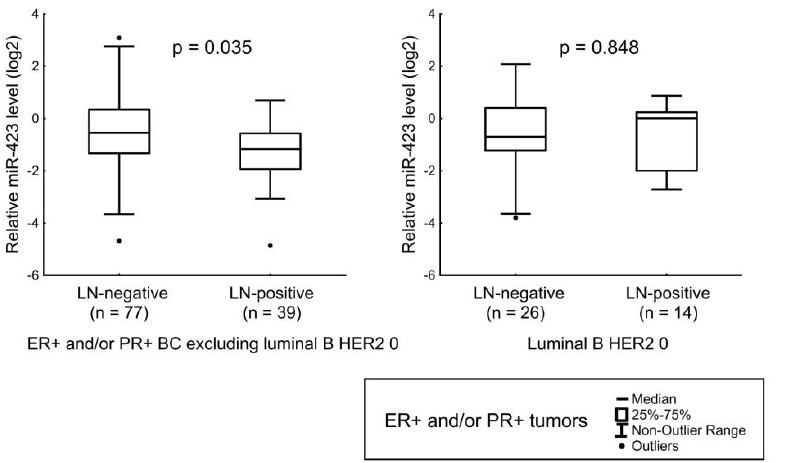
Figure 7. Relation of miR-423 level with LNM in luminal A, luminal B HER2-amplified, and luminal B HER2 1+ tumors (left); relation of miR-423 level with LNM in luminal B HER2-non-expressing tumors (right). The Y axis presents the expression level (log the control (normal